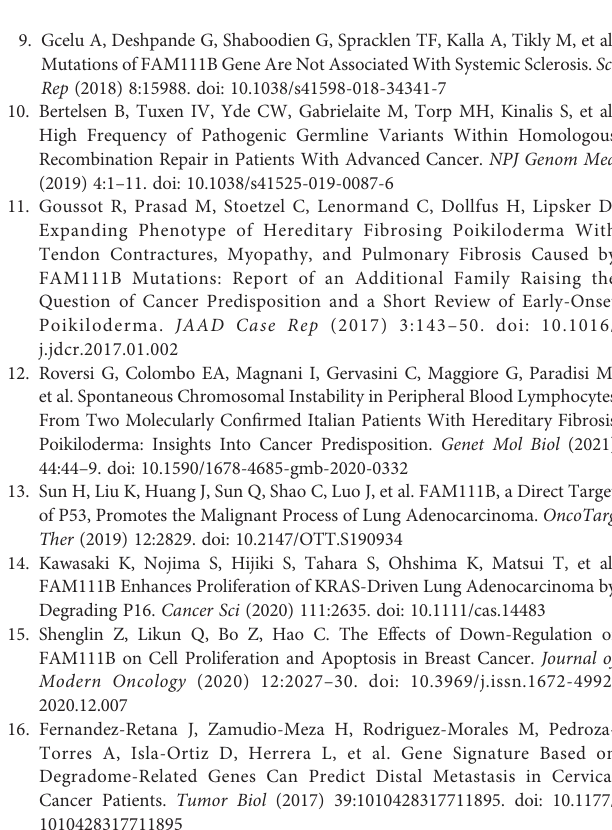
Supplementary Table 1 | List of reported FAM 111B gene mutation and associated clinical